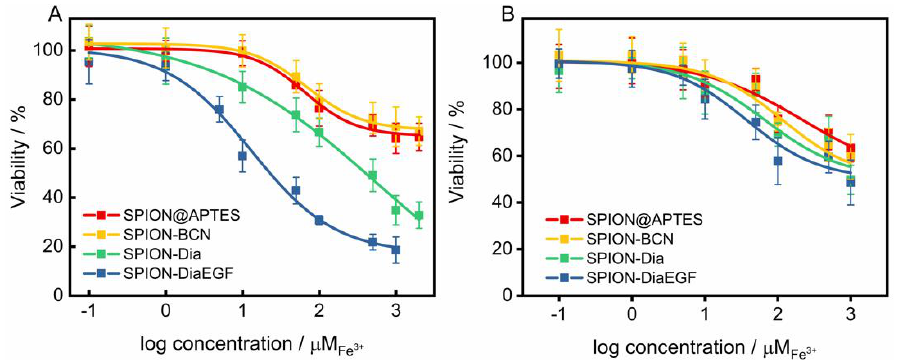
Figure 6. ( A ) Cytotoxicity studies of each particle system on epidermal growth factor receptor (EGFR)-overexpressing (EGFR/+) HCT-116 cells and ( B ) on MDA-MB-453 cell line which served as EGFR negative control (EGFR/−). Cell viability was assessed after 48 h by MTT-assay and plotted as a function of the molar iron concentration. Each point represents the mean ± SD of at least 3 independent experiments, performed in quadruplicate. Corresponding half maximal inhibitory concentration ( IC50 ) and enhancement factor (EF) values are shown in Table 1. Table 1. Corresponding half maximal inhibitory concentration ( IC50 ) values and enhancement factor ( EF ) derived from Figures 6 and 7 of the respective particle based anti-tumor systems. Since the IC50 was not reached for SPION@APTES and SPION@BCN, specification of the EF was not possible for these particle systems. The targeting effect is defined as the ratio of the IC50 values of the non-targeted compound (SPION-Dia) to the targeted compound (SPION-DiaEGF). The gain in specificity is the ratio of the targeted EF to the non-targeted EF